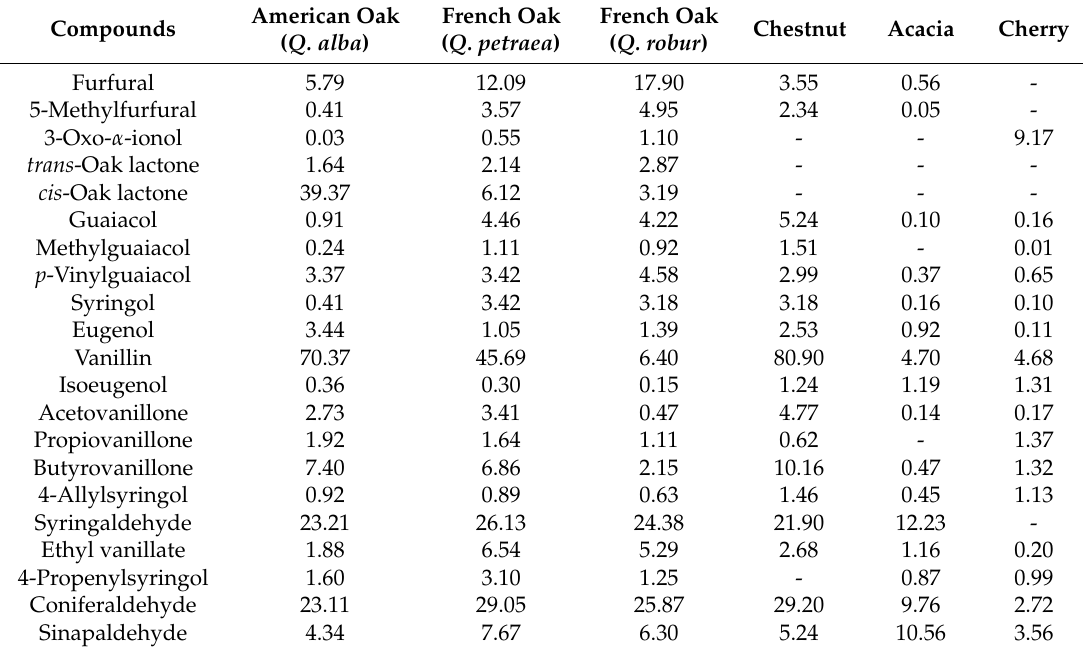
Table 1. Volatile composition ( µ g/g) of different untoasted woods with potential use in enology [13,14]. American Compounds